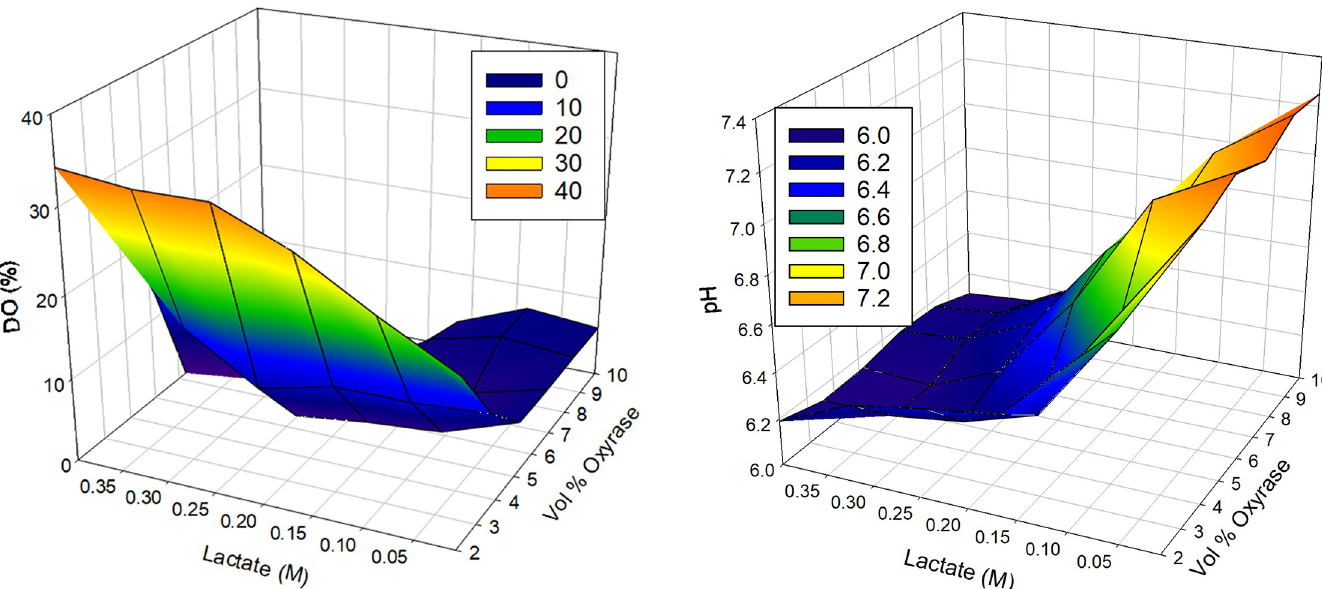
Fig 3. A. 3-dimensional map of DO mapped over lactate molarity and vol% Oxyrase. DO measurements are mapped as a function of added lactate and Oxyrase concentrations in PBS. B. 3-dimensional map of pH mapped over lactate molarity and vol% Oxyrase. pH measurements are mapped as a function of added lactate and Oxyrase concentrations in PBS.